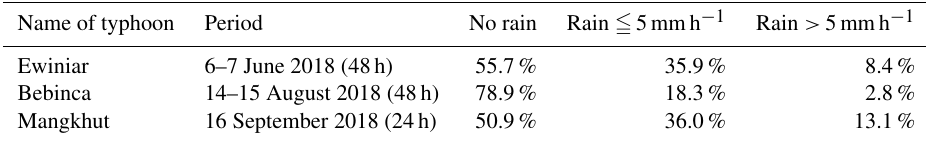
Table 2. Information on the three examples of typhoon events that made landfall in South China in